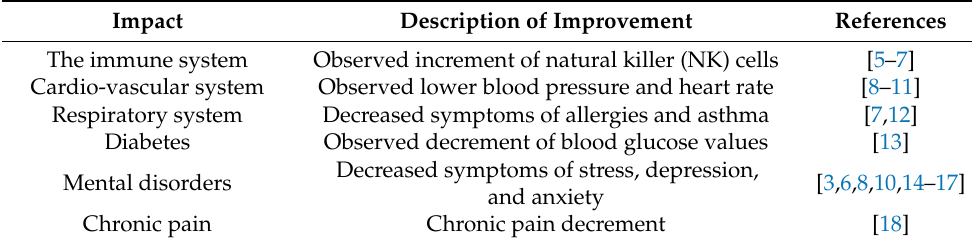
Table 1. Positive impacts of trees and forests on human